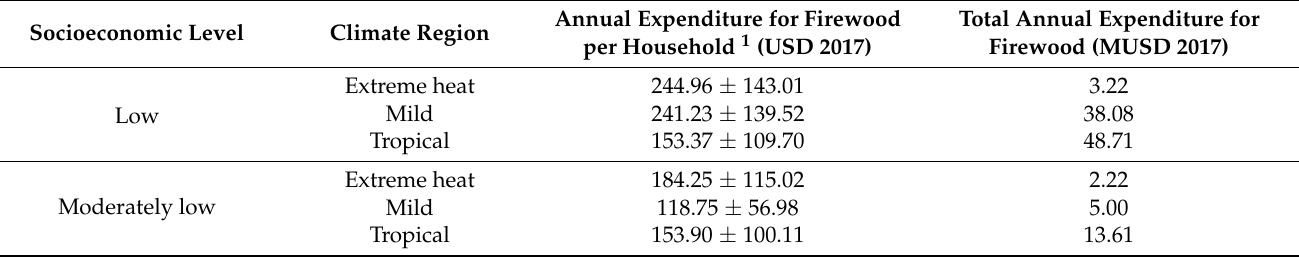
Table 2. Annual expenses per household and total expenditure for all EFU households for acquiring firewood